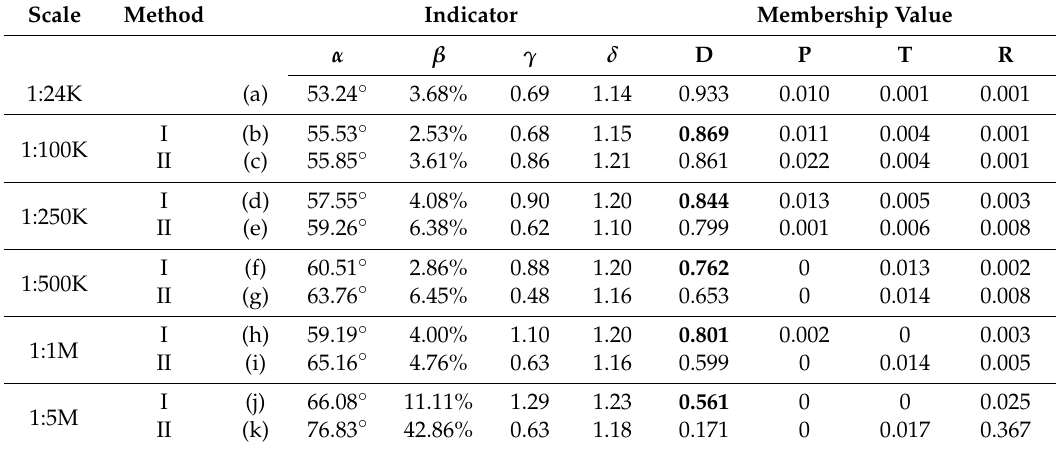
Table 6. Assessment result of dendritic case at different scales.